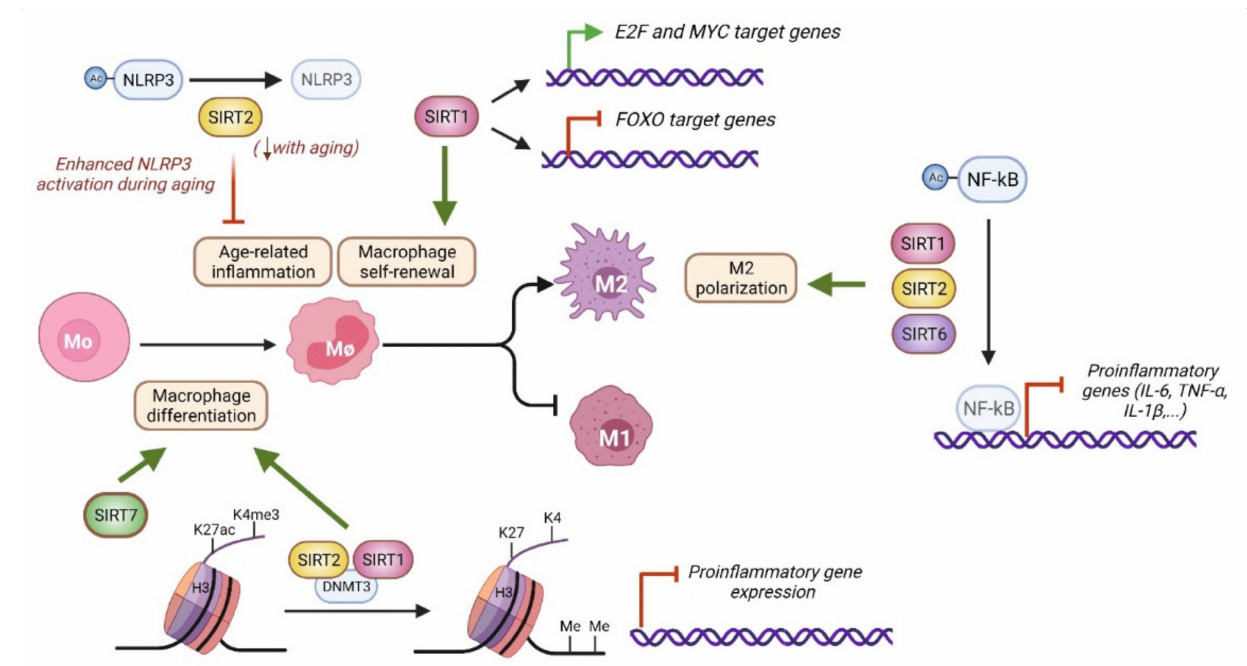
Figure 4. Molecular pathways related to nuclear sirtuin activity in macrophages. Macrophages differentiate from bone marrow cells or self-maintain through local proliferation. After antigen challenge, macrophages polarize into M1 and M2 subtypes. SIRT1 and SIRT2 prevent the premature expression of proinflammatory genes during macrophage differentiation by controlling chromatin structure, including DNA methylation and H3K27ac and H3K4me3 levels [47]. SIRT1 also regulates macrophage self-renewal through MYC, E2F and FOXO dependent pathways [42]. SIRT2 limits age dependent inflammation through NLRP3 deacetylation [63]. SIRT7 stimulates monocyte to macrophage differentiation, but the underlying molecular mechanism remains unclear [64]. SIRT1, SIRT2, and SIRT6 promote M2 polarization by limiting NF-kB activity and reducing the expression of proinflammatory cytokines